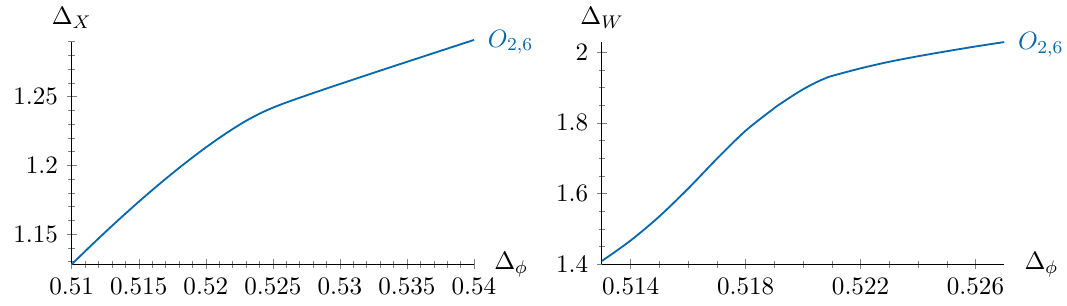
Figure 5: Upper bound on the dimension of the first scalar X and the first scalar W × φ operator in the φ OPE as a function of the dimension of φ in the O ar bs